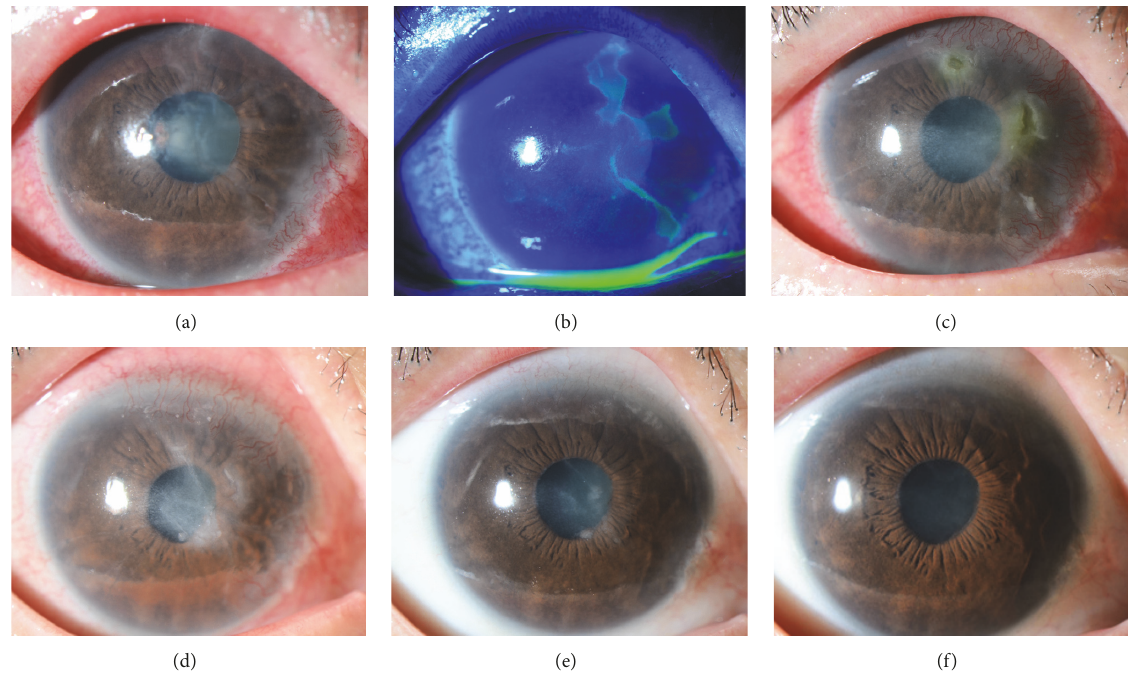
Figure 1: Slit-lamp images of the right eye showing the clinical course.(a) One week after the trigeminal nerve block, corneal epithelial defects, severe conjunctival hyperemia all around the periphery, cloudy and irregular corneal epithelium and Descemet’s membrane folds, and mild stromal edema were noted. (b) One week after the trigeminal nerve block, the corneal epithelial defects were shown using fluorescein staining. (c) One month after the nerve block, PED were noted. Severe conjunctival hyperemia, very severe corneal superficial neovascularization at 11 to 5 o’clock, and corneal stromal edema in the central cornea were also observed. (d) Two months after the trigeminal nerve block, the epithelial defects were improved but SPK, corneal superficial neovascularization at 11 to 5 o’clock, irregularity of corneal epithelium, and stromal scarring in the central cornea remained. (e) Five months after the nerve block, slight irregularity of corneal epithelium and stromal scarring in the central cornea were observed. Corneal superficial neovascularization showed signs of improvement although SPK remained. (f) Six months after the nerve block, SPK and conjunctival hyperemia, corneal superficial neovascularization, and corneal stromal edema were all